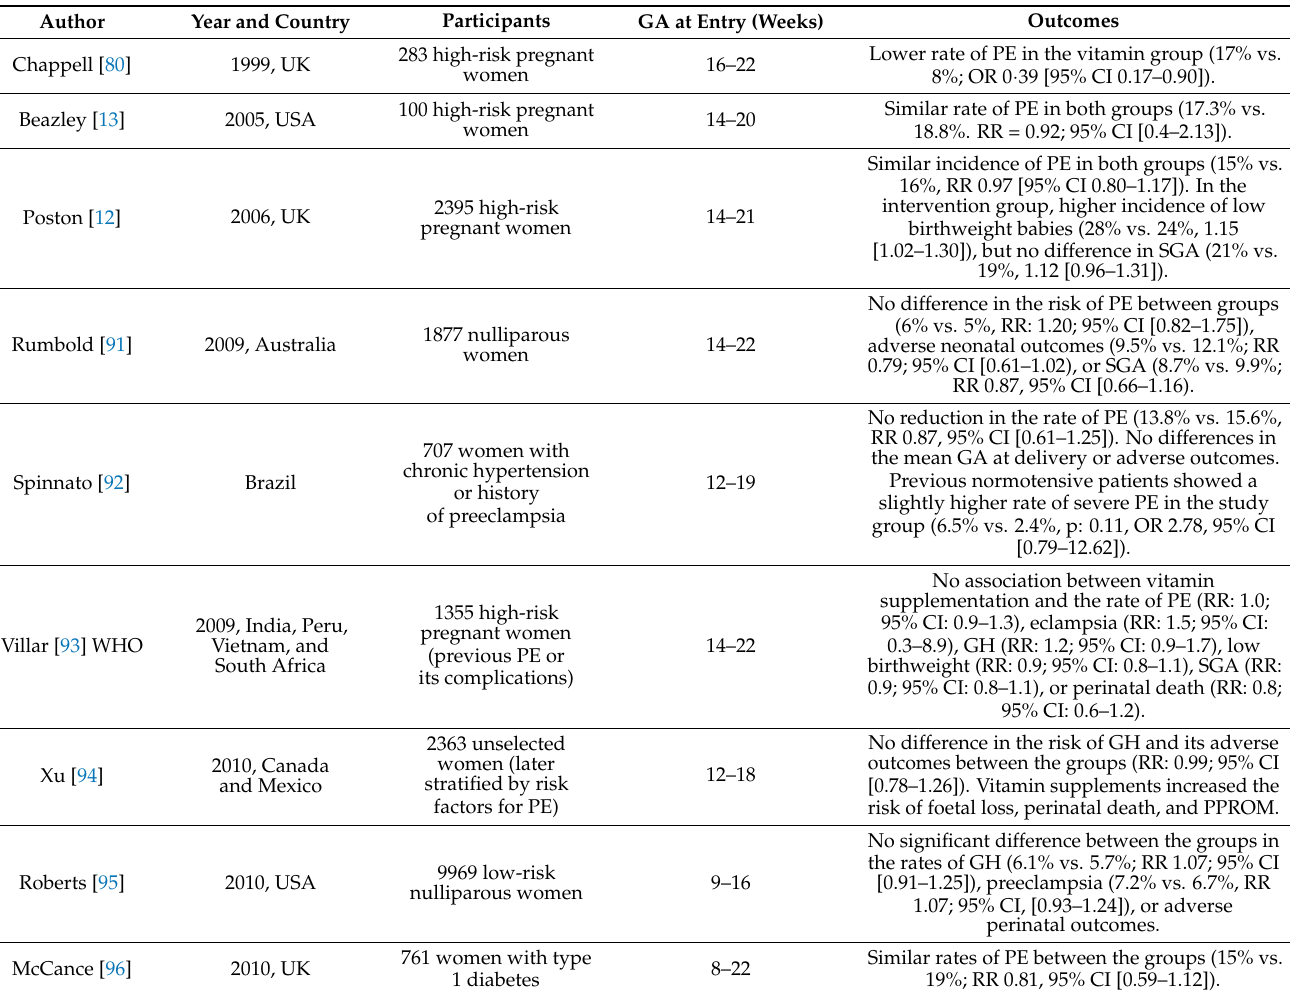
Table 1. Nine trials involving a total of 19,810 women were included and randomly assigned to the placebo or vitamin C (1000 mg) + vitamin E (400 IU). Meta-analysis by Conde-Agudelo [87]. PE =